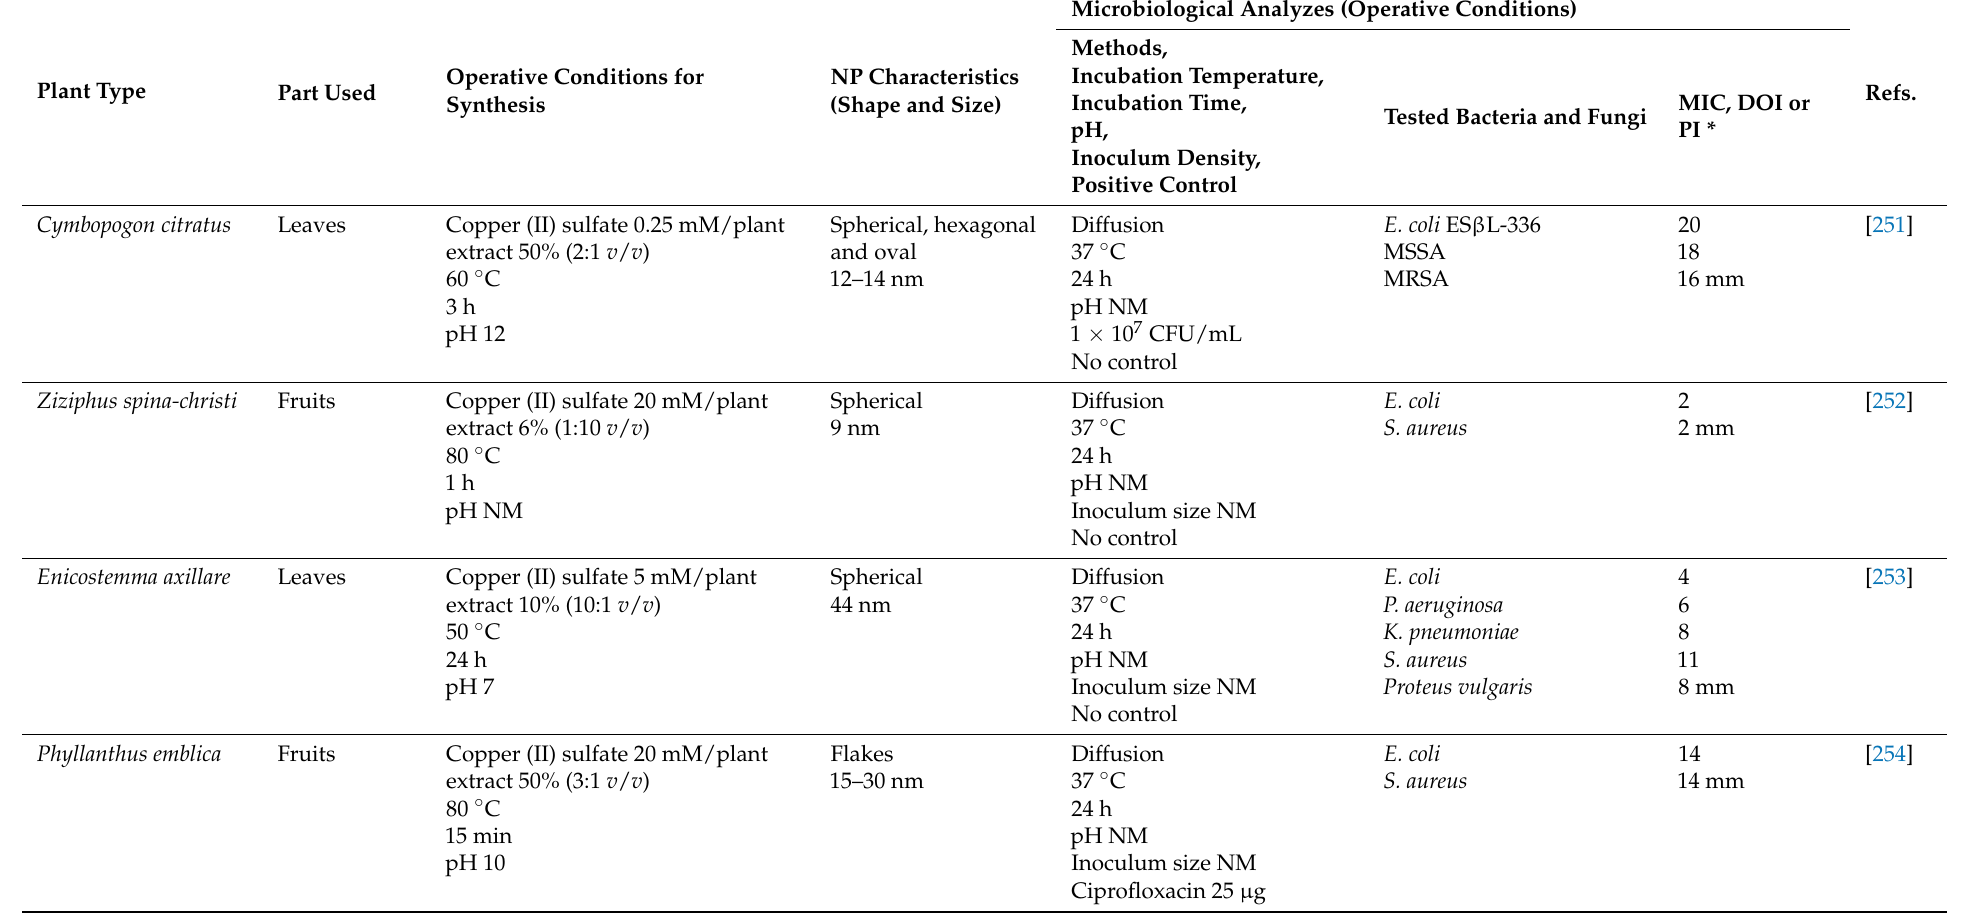
Table 7. Green copper nanoparticles exhibiting antimicrobial